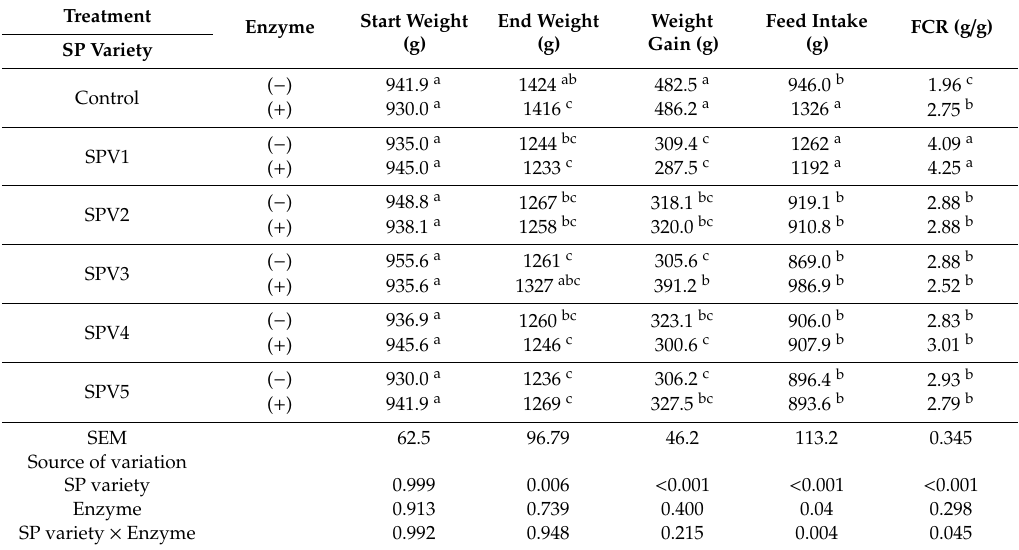
Table 7. Summary of main e ff ects of diet and enzyme on performance parameters of broilers.